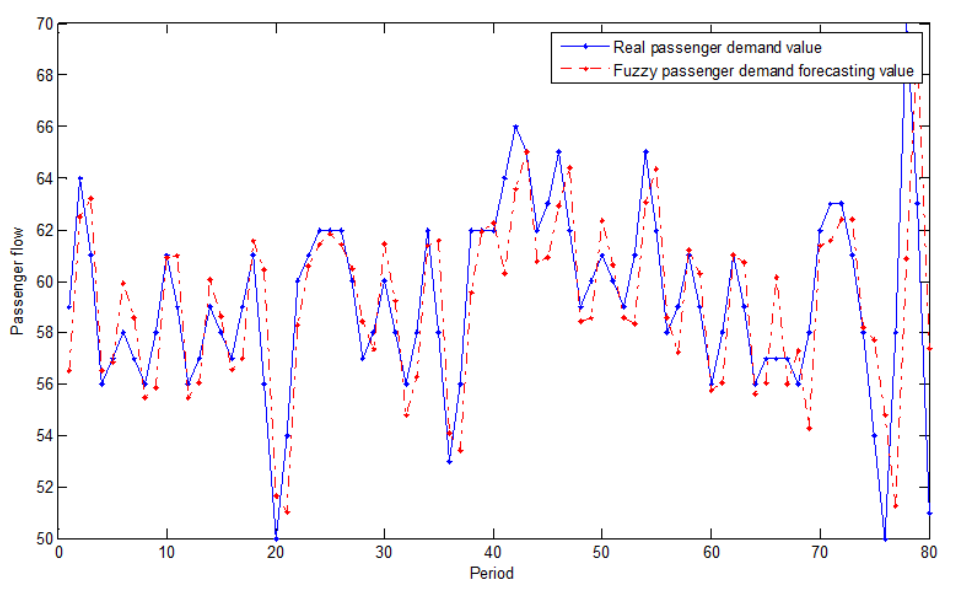
Figure 3. Comparison of predictive value and real value